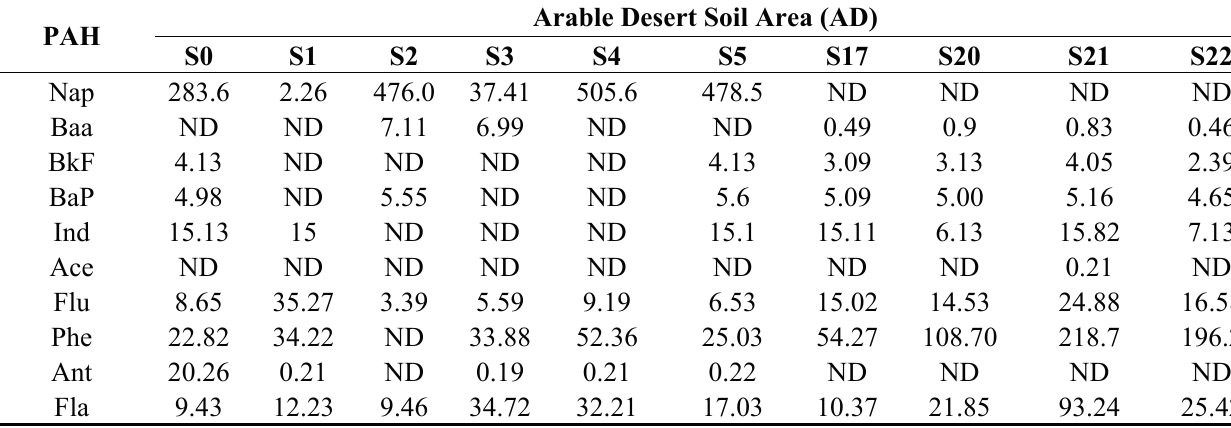
Table 1. Distributions of different PAHs in sample soils from three areas: Urban and residential areas (RD), around oil wells (OW), and in the arable desert soil area (AD) ( μ g·kg − 1 ), not detectable